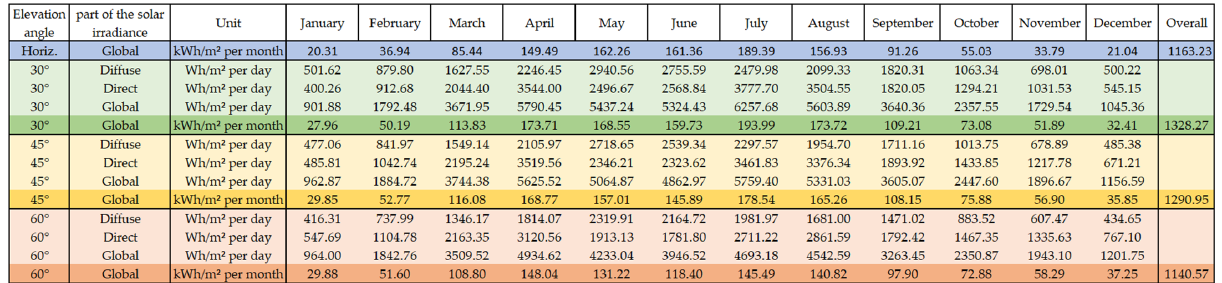
Figure 18. Energy yield per day in Wh/m² and per month in kWh/m² for an inclined PV system oriented towards the south.